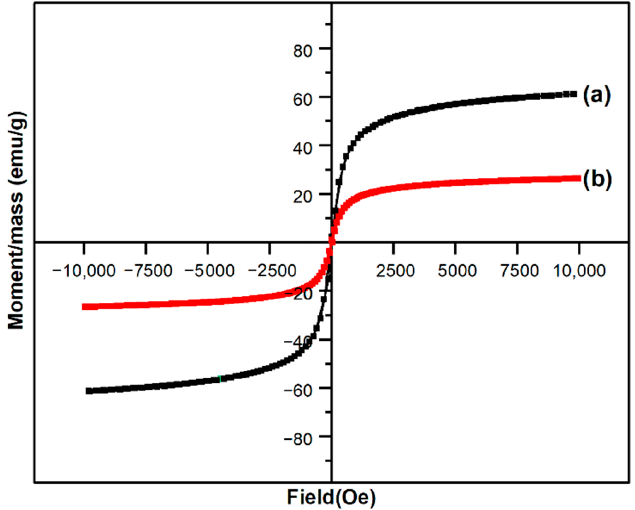
Figure 4. M vs. H curves for pristine Fe 3 O 4 ( a ) and 10G/Alg/FA/Fe 3 O 4 film ( b ).